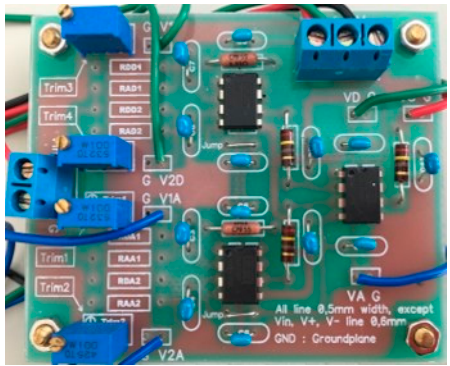
Figure 6. Photograph of the amplifier circuit by the active-dummy method.